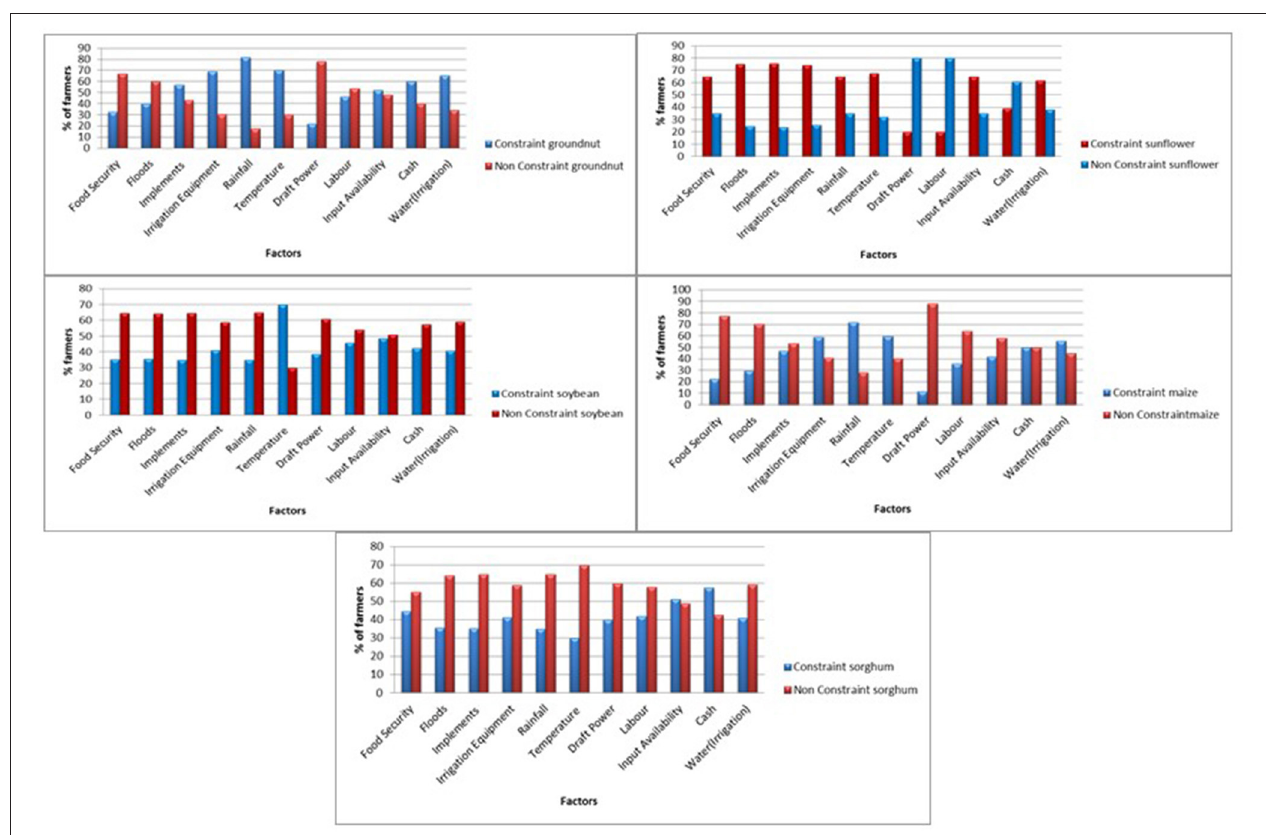
FIGURE 4 | Factors influencing the choice of grain crop production in the Free State Province.